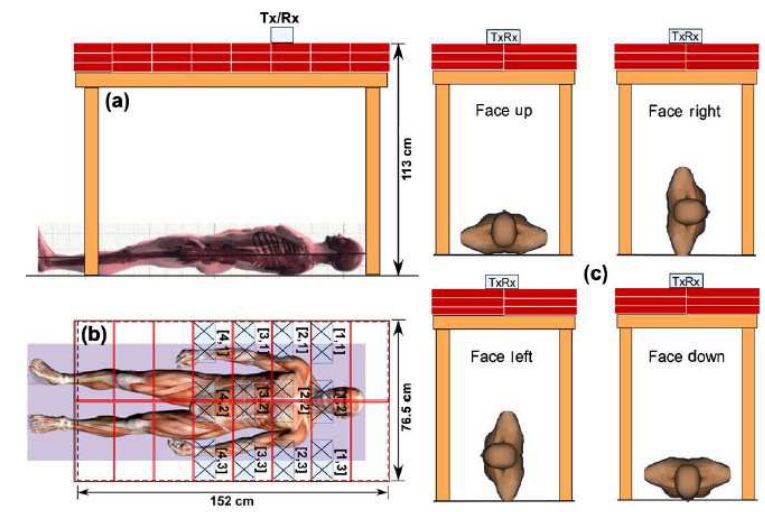
Figure 13. Experiment setup of the step frequency continuous wave ( SFCW ) radar to detect a human through brick: ( a ) size view, ( b ) top view, and ( c ) postures [124].